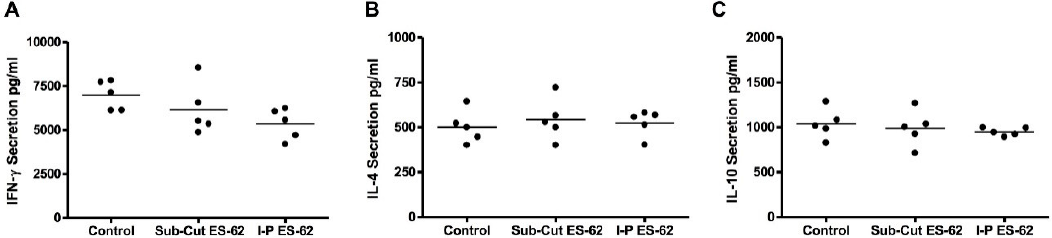
Figure 3. Effects of sub ‐ cutaneous or intra ‐ peritoneal treatment with ES ‐ 62 on composition of BDC2.5NOD splenocyte populations. Four ‐ week ‐ old BDC2.5NOD mice were given two injections of 2 μ g ES ‐ 62 over the course of a week. After one week, splenocytes were harvested, and the percentage of B cells, CD4 + cells, and CD4 + CD25 + cells was assessed by staining with ( A ) anti ‐ CD19, ( B ) anti ‐ CD4, and ( C ) anti ‐ CD25, and subsequent FACS analysis. Each dot on the scatter plot corresponds to one individual mouse.